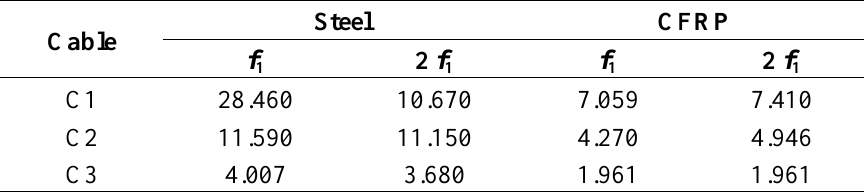
Table 8. Response amplitudes of parametric vibration (units: